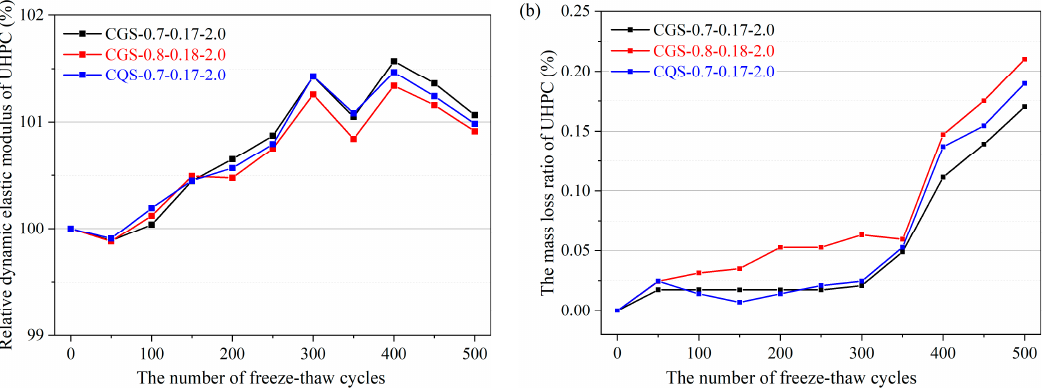
Figure 10. The freezing–thawing resistance of UHPC under different numbers of freeze–thaw cycles: ( a ) relative dynamic elastic modulus; ( b ) mass loss ratio.